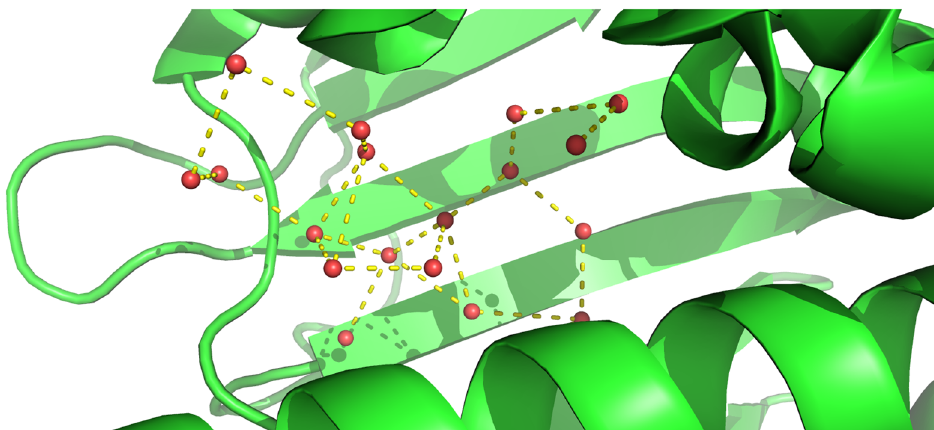
Fig. 2 Network of water molecules in binding sites. Example of crystallographic water molecules in the binding site of the apo structure of HSP90 (PDB (Protein Data Bank)-id: 1uyl). As water molecules in the binding site are stabilized by hydrogen-bond interactions to nearby water molecules, models that rely purely on protein – water interactions fail to represent the thermodynamic state and therefore to predict position, enthalpy and entropy of water molecules.